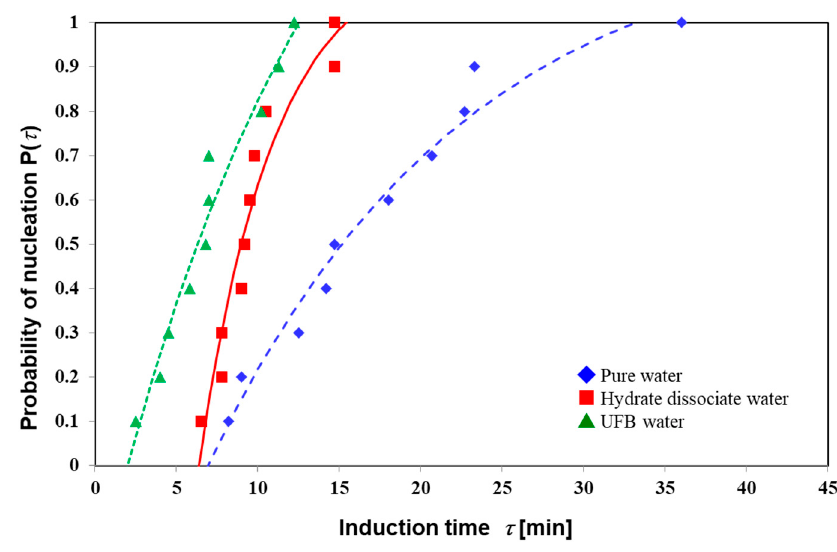
Figure 4. Probability of nucleation vs. induction time. Each point shows the experimental data (numerical data are available in Table A1 ) and each line shows the fitting curve of Equation (1).